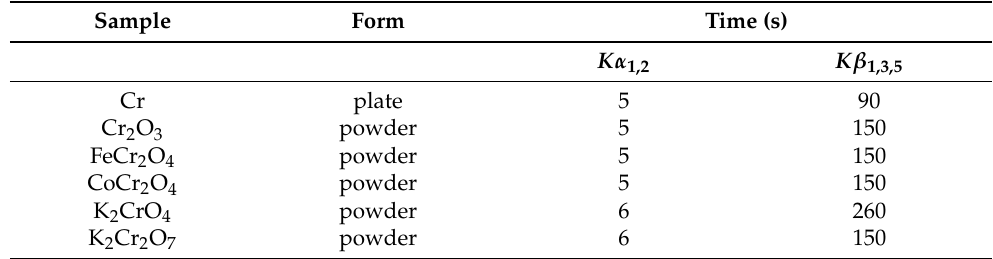
Table 3. The measurement conditions of K α , β emission lines in Cr compounds. See text for details.